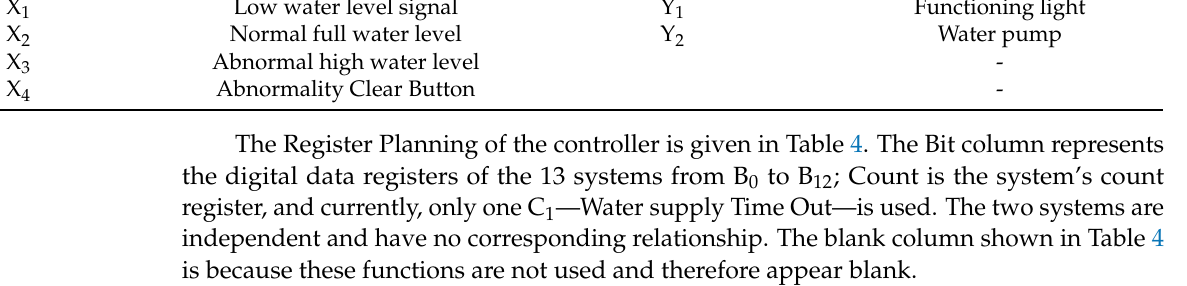
Figure 5. Oil–water mixer with the Intelligent Programmable IoT Controller.